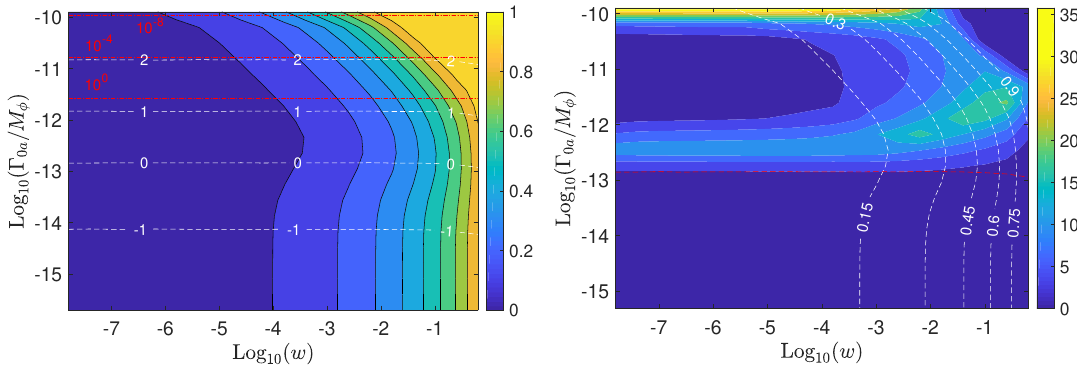
Figure 10. Left panel : contours of the (cid:12)nal temperature ratio obtained numerically, x f;n = T b =T a , shown in color, for an in(cid:13)aton with axionic couplings to gauge bosons in both sectors. The white dashed contours show log ( T rh =M (cid:30) ). The red dot-dashed lines mark the region where T a; max = (cid:3) a 10 for initial in(cid:13)aton densities (cid:26) (cid:30);I = 10 (cid:0) 8 M 2 M 2 , 10 (cid:0) 4 M 2 M 2 and 10 0 M 2 M 2 . Right panel : contours Pl (cid:30) Pl (cid:30) Pl (cid:30) of relative fractional discrepancy, j x f;a (cid:0) x f;n j =x f;n , where x f;a is the analytic estimate of eq. (4.16) with eq. (4.27), in percent. The white dashed contours depict x f;n and the red dashed line indicates where T rh = M (cid:30) .